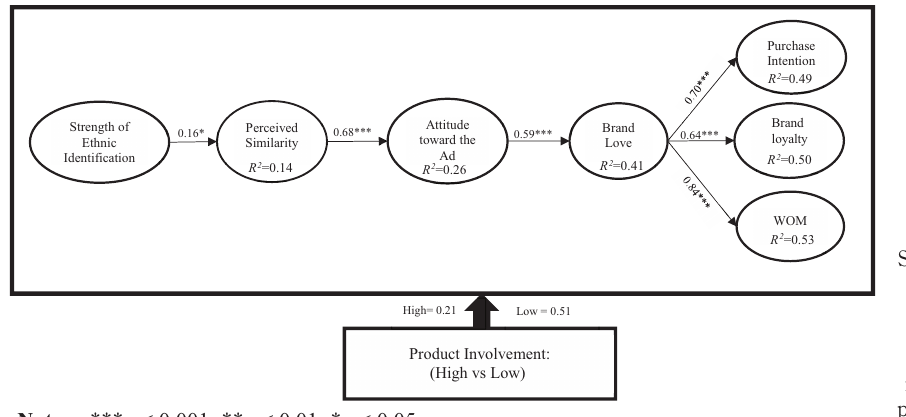
Figure 2. Study 2 – conceptual model of the antecedents and outcomes of brand love and the moderation effect